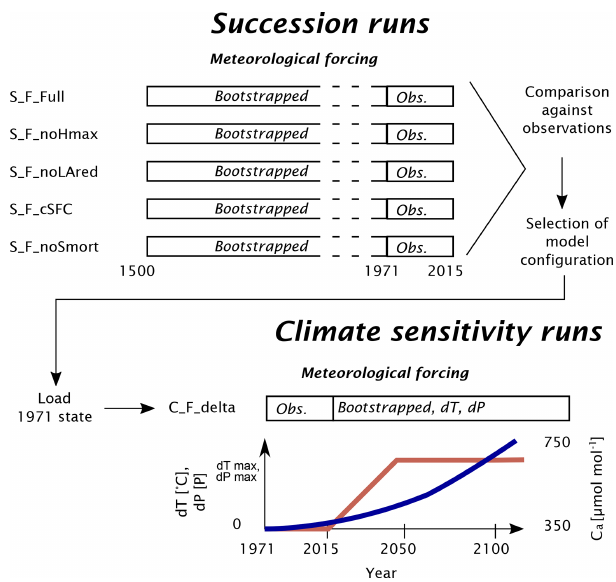
Figure 4. Workflow of the various simulation experiments con- ducted in this study. The succession runs (S_) use bootstrapped me- teorological forcing for 470 years, followed by observed forcing for the period 1971–2015. FORHYCS is run with several configu- rations, as described in Table 1. The output from each run is then compared against observations, based on which one configuration is selected for the runs under idealized climate change (C_). The modifiers for temperature and precipitation (red line) are scaled lin- early between 0 and their maximum in the period 2016–2050. At- mospheric CO 2 concentration C a (blue line, approximate illustra- tion) has no effect on the temperature and precipitation modifiers but impacts the canopy